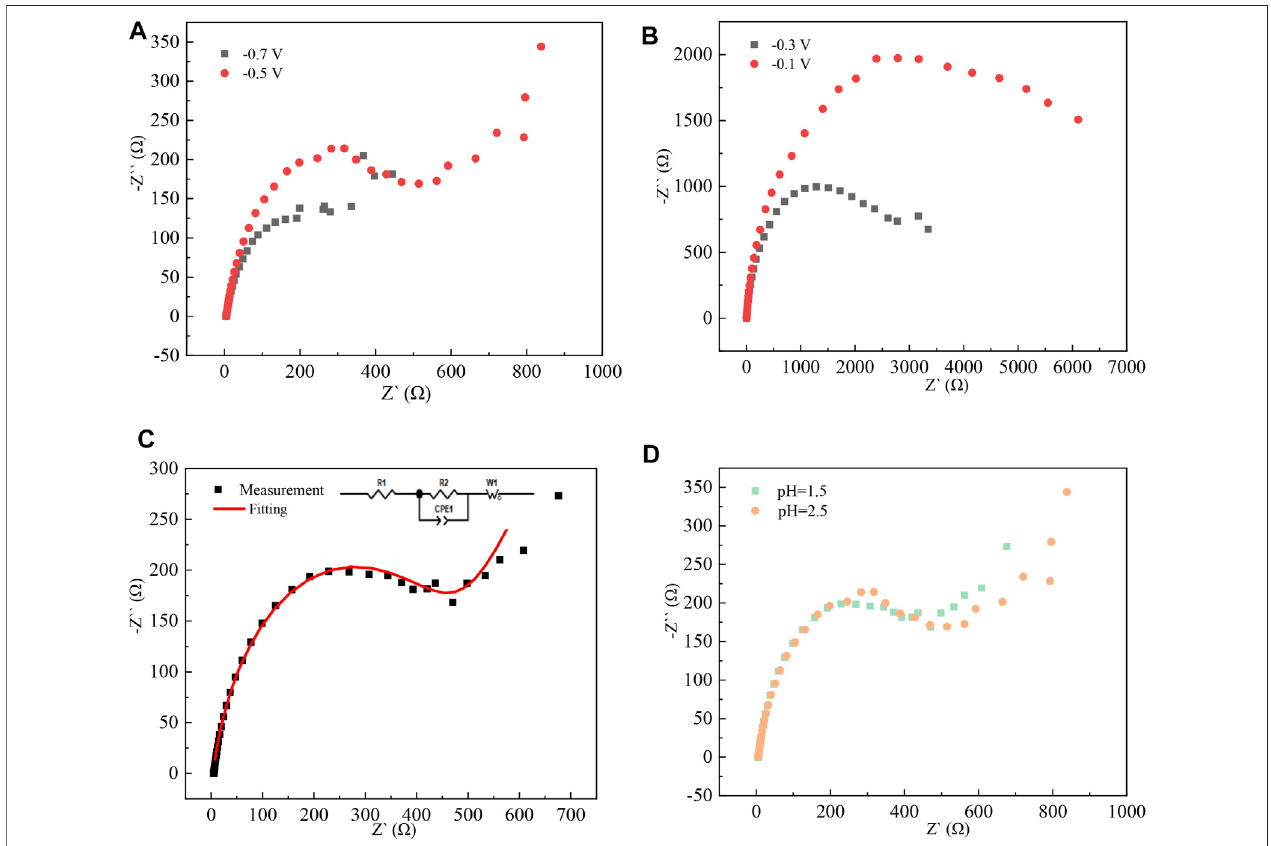
FIGURE9| Nyquistpatternofhigh-purityindiumpreparedbyelectrodepositionatdifferentpHvalues: (A) pH=2.5,potential − 0.7 V, − 0.5 V; (B) pH=1.5,potential − 0.3 V, − 0.1 V; (C) pH = 1.5, potential − 0.5 V; and (D) potential of − 0.5 V, pH = 1.5,